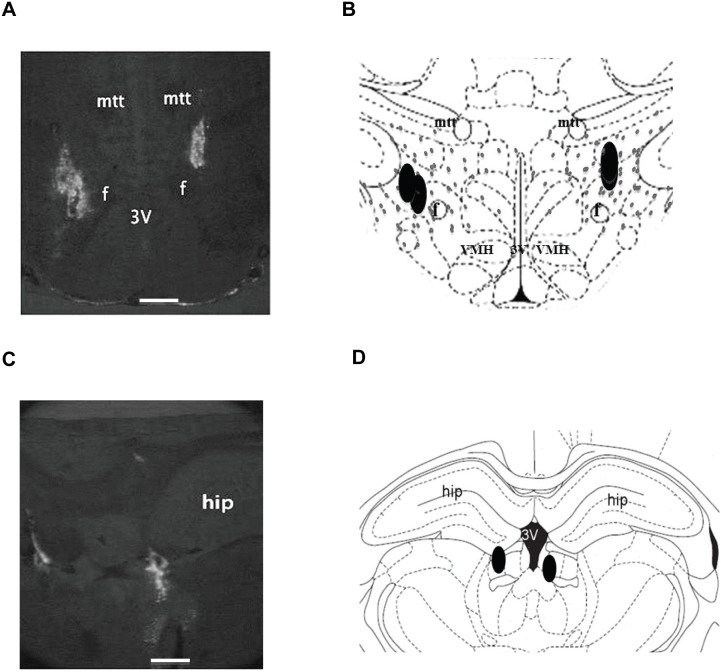
Anatomic locations of the injection sites.(A) Representative cross section showing the injection sites (fluorescent beads) located within the lateral hypothalamic area (LHA), two injections on each side (note: two injections were overlapping on one side). (B) Schematic corresponding section of A illustrating the injection sites (black) and the distribution of MCH neurons (small grey dots, modified from (Paterson & Hahn 2010)) in the LHA. (C) Representative section and (D) the schematic corresponding section from a rat showing the injection sites localized outside the LHA in the hippocampus. Abbreviations: 3v, third ventricle; f, fornix; hip, hippocampus; mtt, mammillothalamic trac; VMH, ventromedial hypothalamus. Scale bar represents 0.5 mm.